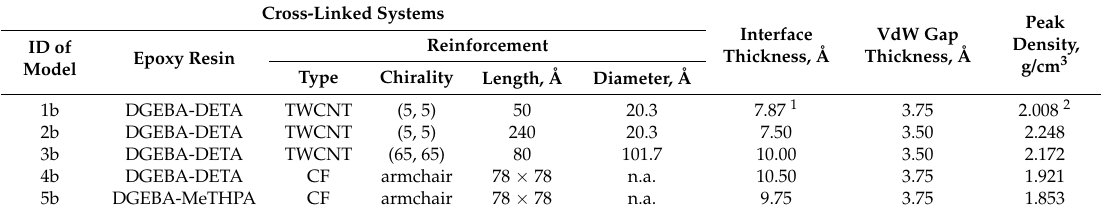
Table 3. Structural characterization of interface region in cross-linked epoxy resin nanocomposites.